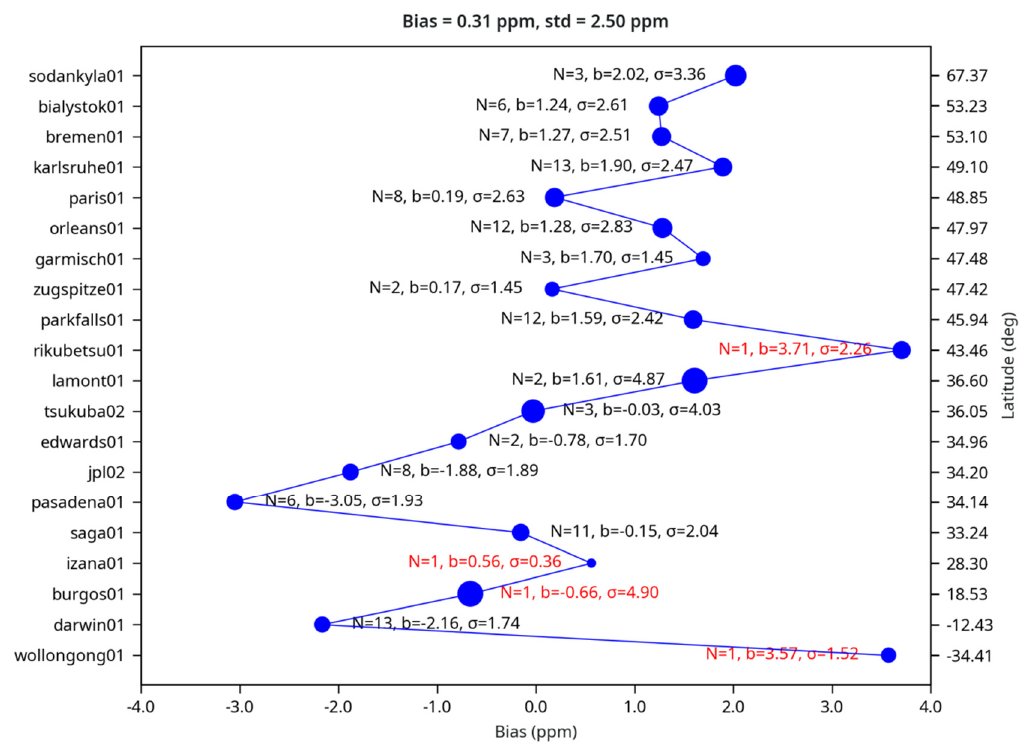
Figure 4. The bias of each TCCON site as a function of latitude. N is the number of collocations, b is the averaged bias, and σ is the averaged SD. The size of the blue dots indicates the value of σ . The std is the overall mean SD.